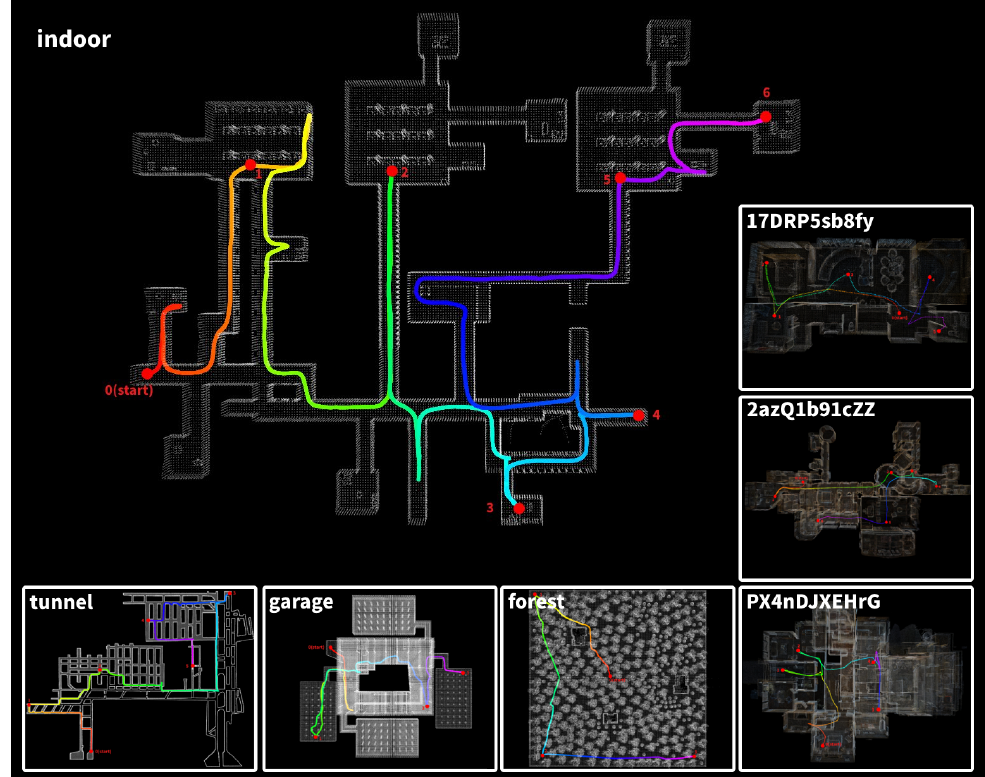
Figure 15. The overall view of seven different environments.